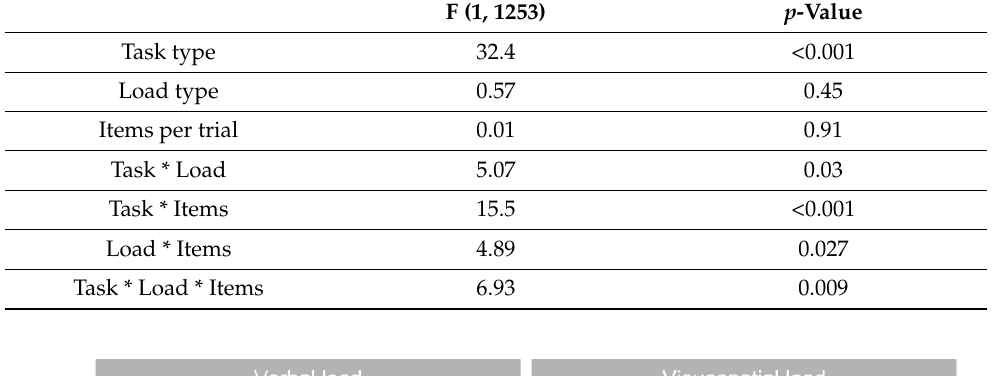
Table 1. Three-way ANOVA results for relative accuracy.